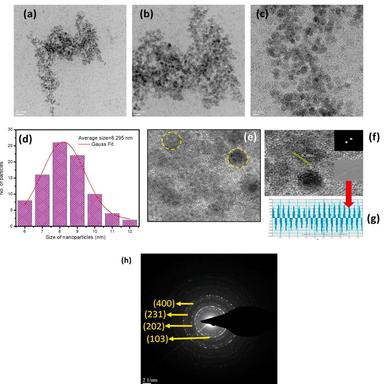
(a–c) TEM image of an LBG-cl-PAN/IONP HNC at three different magnifications. (d)A particle size distribution histogram determined from the TEM images; (e) TEM image showing spherical Fe3O4 with the size particles ~8.2 nm inside the HNC; (f) Lattice fringes of IONPs in the HR-TEM image; (g) Fe3O4 structure with the inset of FFT and iFFT patterns; (h) TEM image of a representative sample of LBG-cl-PAN/IONP HNC displaying selected area electron diffraction (SAED) pattern.